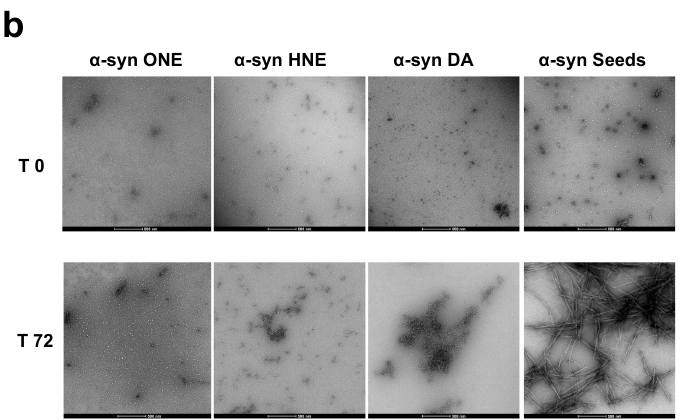
Figure 5. In vitro seeding assay. ( a ) Th-T assay for samples collected at different time points (as indicated) for α-syn monomers (25 μM) incubated alone or with 5 uM α-syn seeds or different oli- gomers at 37 °C, 800 rpm. ( b ) TEM images for samples collected at different time points (T 0 and T 72). Scale bar—200 nm.